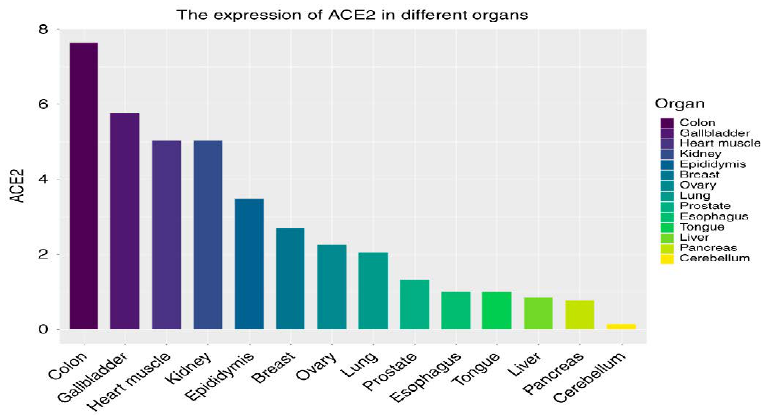
Figure 2. Organ-specific comparative ACE-2 expression. Figure replicated from [13] with permission.